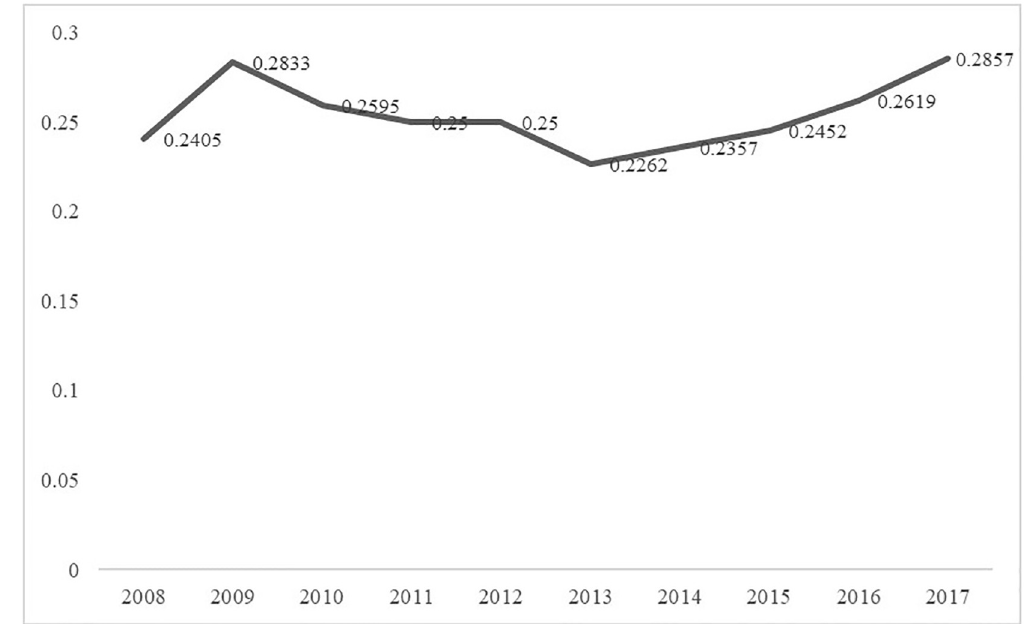
Fig 2. Network density of urban innovation in Guangdong.